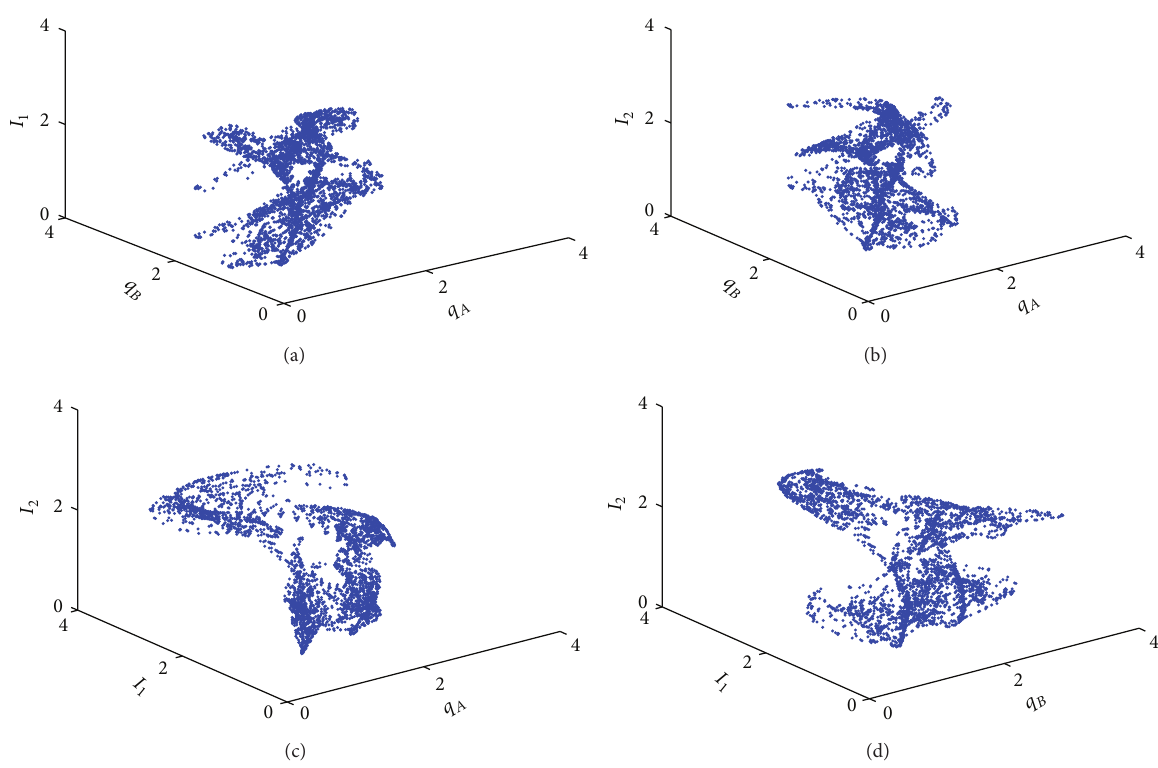
Figure 3: The three-dimensional strange attractors of the dynamical system (10).